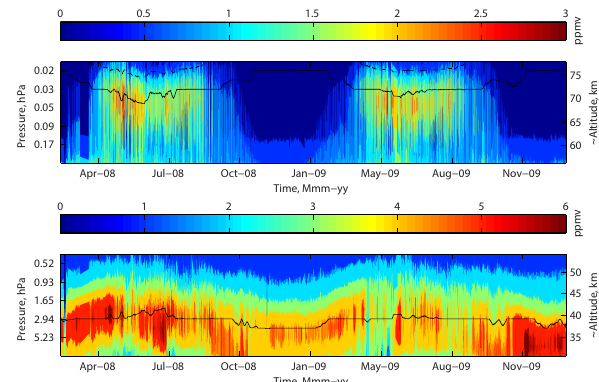
Figure 4. Top panel: BAS-MRT data showing the mesospheric ozone. The solid black line indicates the upper limit of the 0.8 mea- surement response, while the dashed black line indicates the up- per limit of 0.5 measurement response. Bottom panel: stratospheric ozone observations from BAS-MRT. The solid black line indicates the lower limit of the 0.8 measurement response.